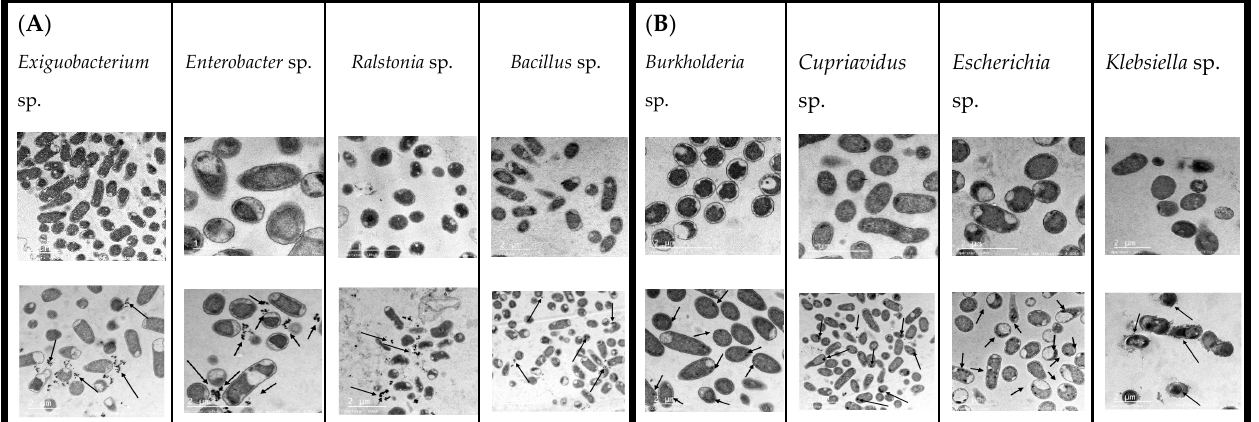
the black arrows indicated intracellular deposits of Cd.